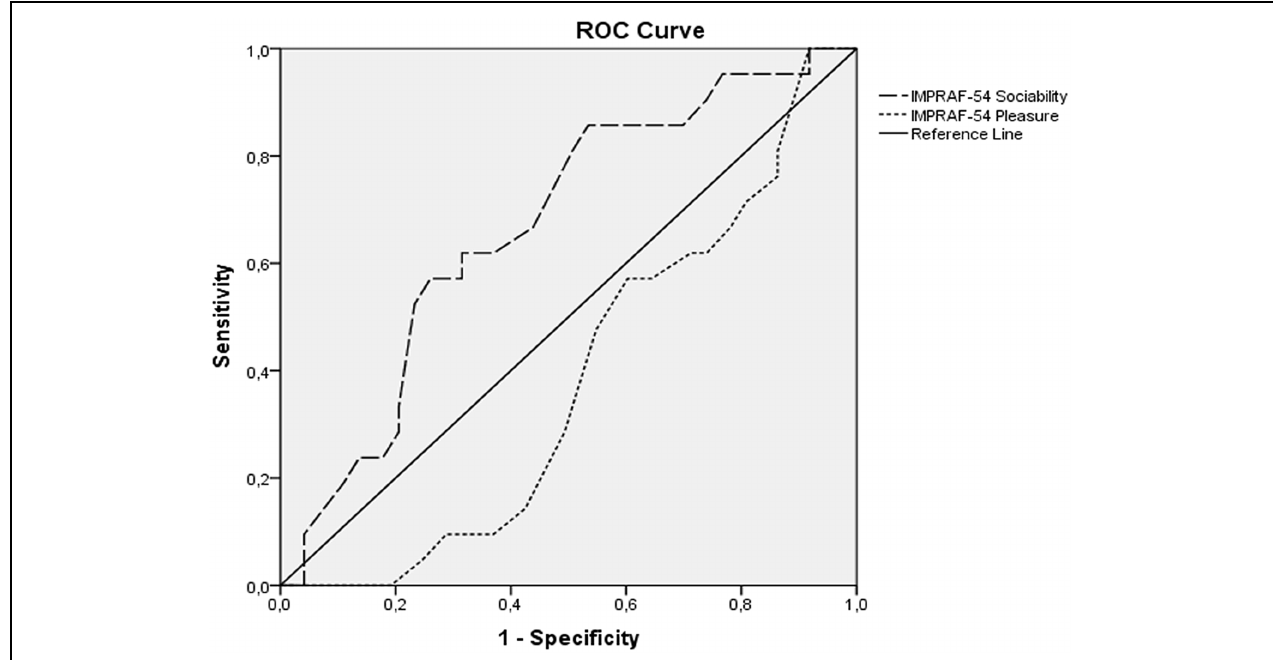
FIGURE 2 | ROC curve for Sensibility/Specificity related to IMPRAF-54 “Sociability” in the CPG and IMPRAF-54 “Pleasure” in the